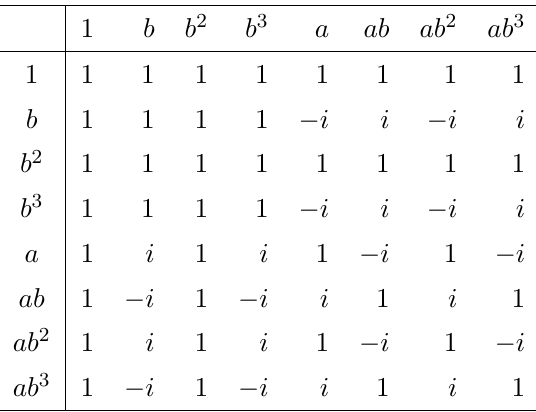
Table 5 . Table of values for ω ( g, h ) for a cocycle representing the nontrivial element of H 2 ( Z 2 × Z U(1)) . 4 ,